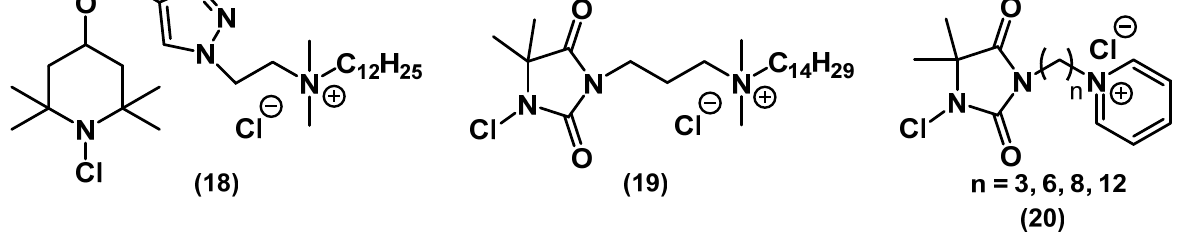
Figure 11. Mono-QACs containing N -chloramines.